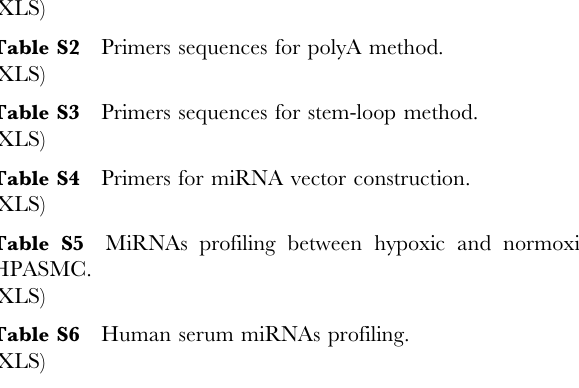
Table S1 Primers and probe sequences for S-PolyT method. Table S2 Primers sequences for polyA method. Table S3 Primers sequences for stem-loop method. Table S4 Primers for miRNA vector construction. Table S5 MiRNAs profiling between hypoxic and normoxic HPASMC. Table S6 Human serum miRNAs